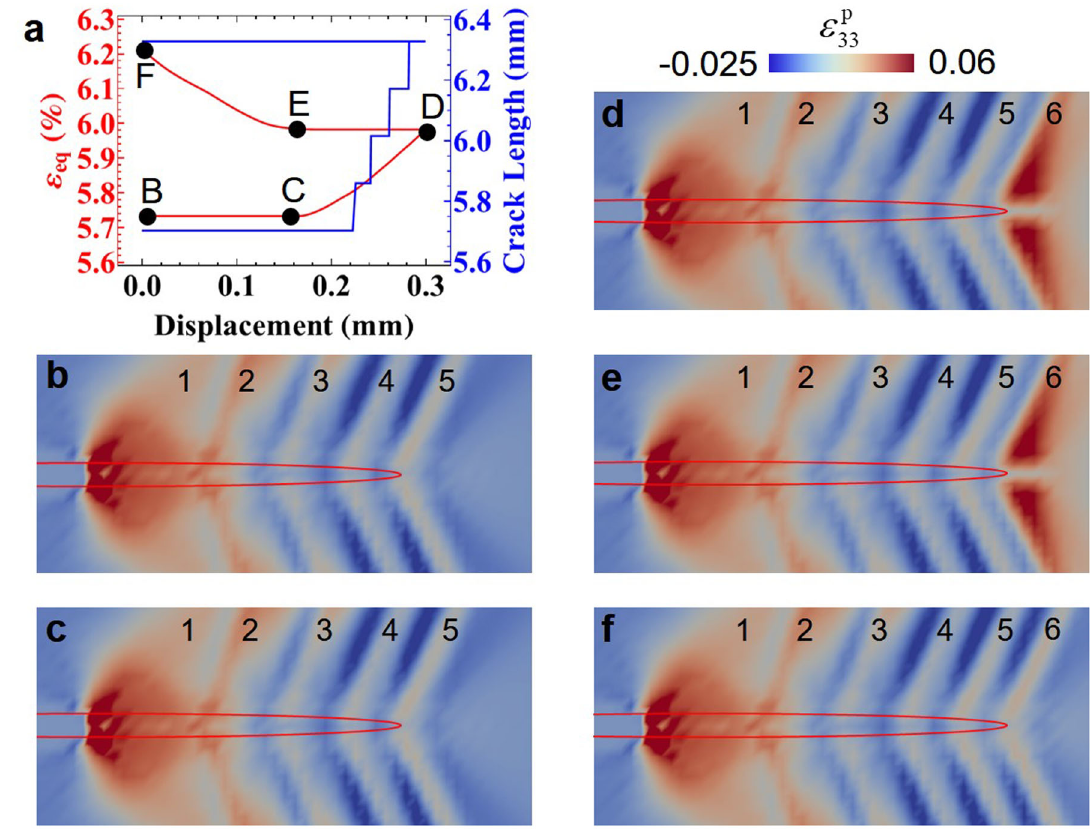
Fig. 7 Evolution of plastic strain during a loading cycle. a Evolution of the average equivalent plastic strain and crack length. b – f Distribution of the plastic strain component along the loading direction, corresponding to Points B-F in ( a ), respectively. The red curve in each fi gure represents the contour of the crack. The color legend is shown on the top right. The numbers on ( b – f ) indicate the numbers of line in Fig. 9a, the crack growth rate is fi tted by da (cid:6) ð Δ J Þ n with dN n (cid:6) 1 : 6. Since Δ J (cid:6) ð Δ K Þ 2 under small scale yielding 1 , the calculated